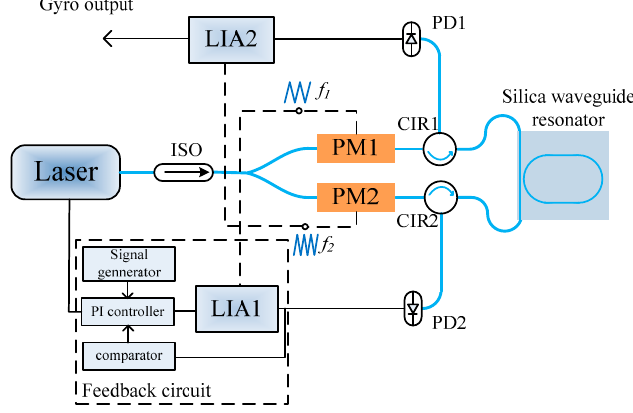
Figure 4. Schematic diagram of the RMOG.